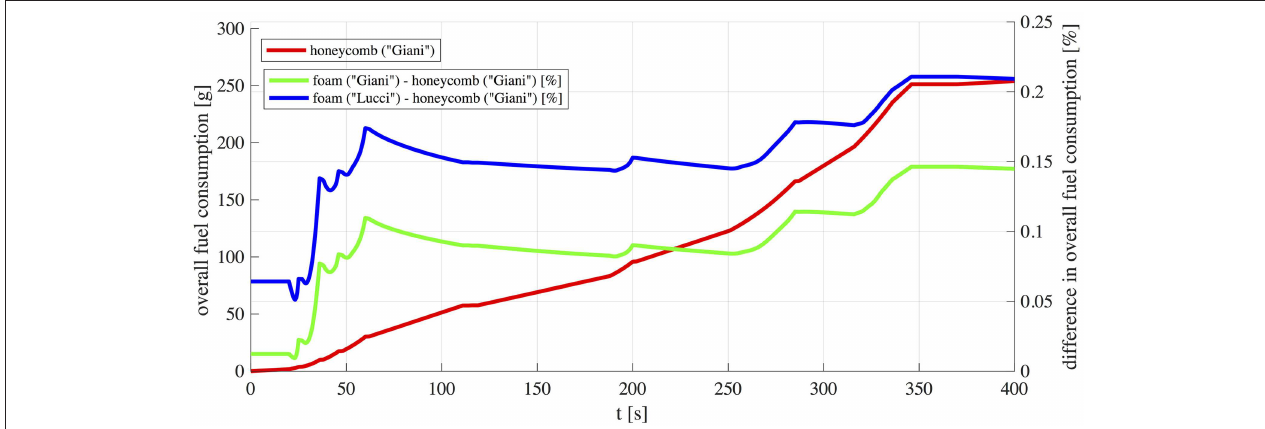
FIGURE 11 | Calculated cumulative fuel consumption during the